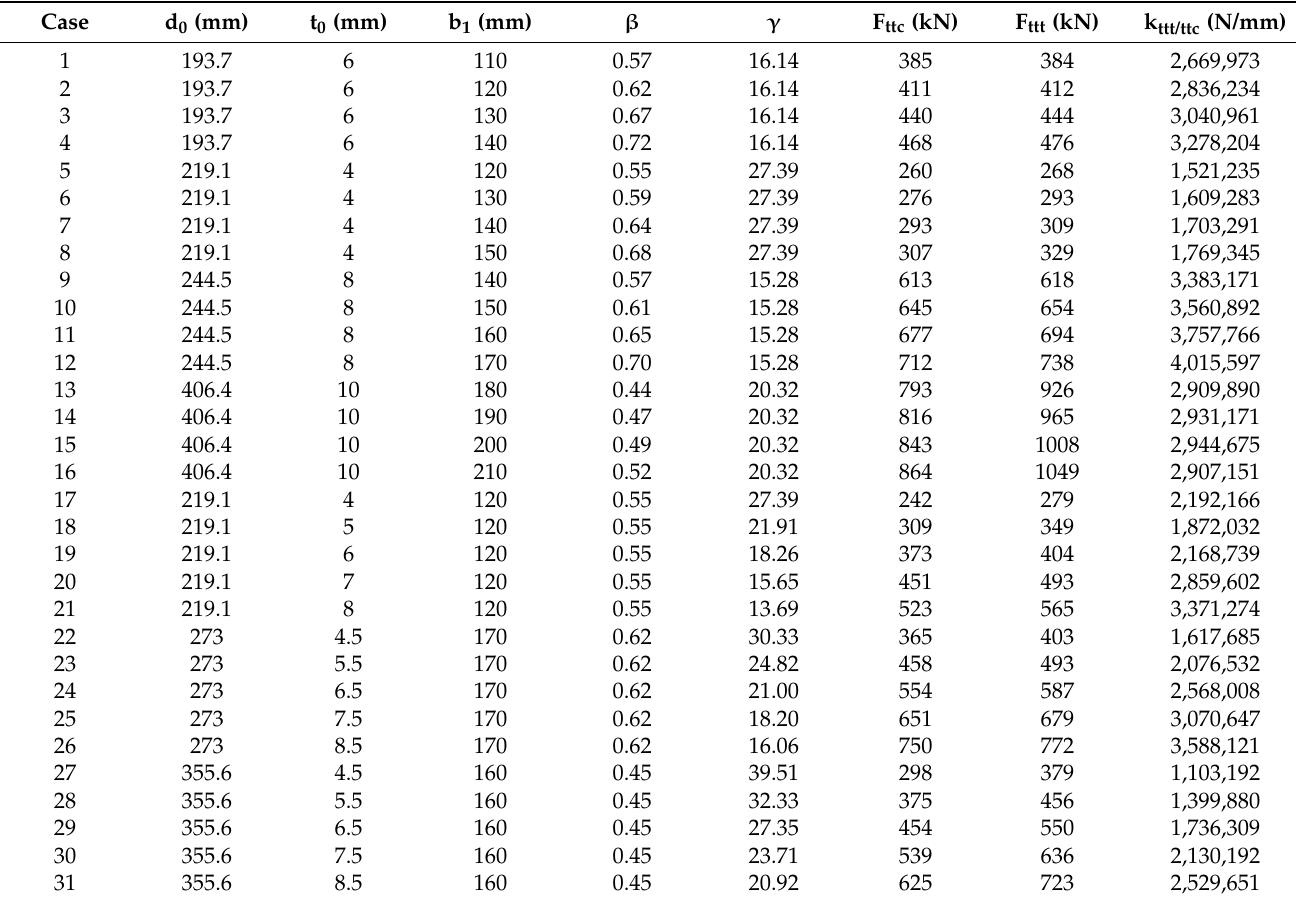
Table 2. Results of the numerical simulations.